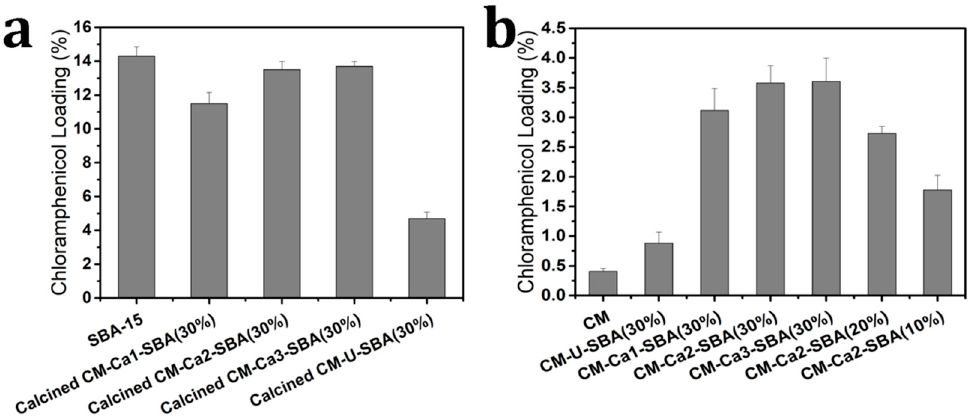
Figure 5. Chloramphenicol loading percentage of ( a ) each particle, and ( b ) dry membrane samples.